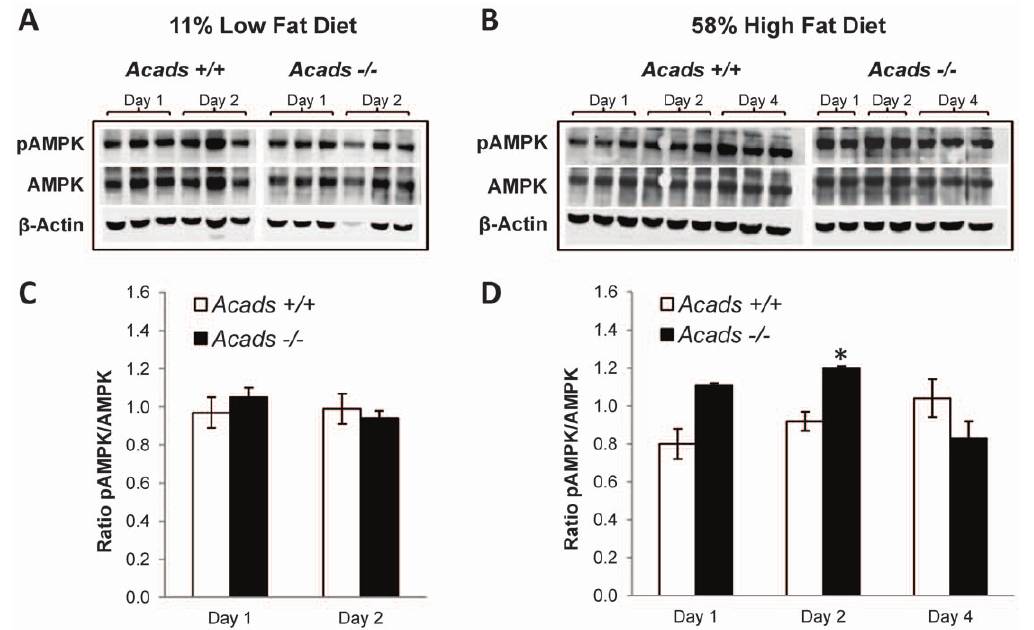
Figure 5. Effects of diet, genotype and day on pAMPK in the hypothalamus. On low-fat diet, there was no effect of genotype on pAMPK level in hypothalamus (A, C). On Day 2 of high-fat diet, Acads 2 / 2 mice showed increased pAMPK levels compared to Acads + / + mice (B, D). Representative immunoblots for total AMPK, pAMPK, and beta actin are shown. n =2–3 per genotype and day. * P , 0.05 vs. Acads + / + .